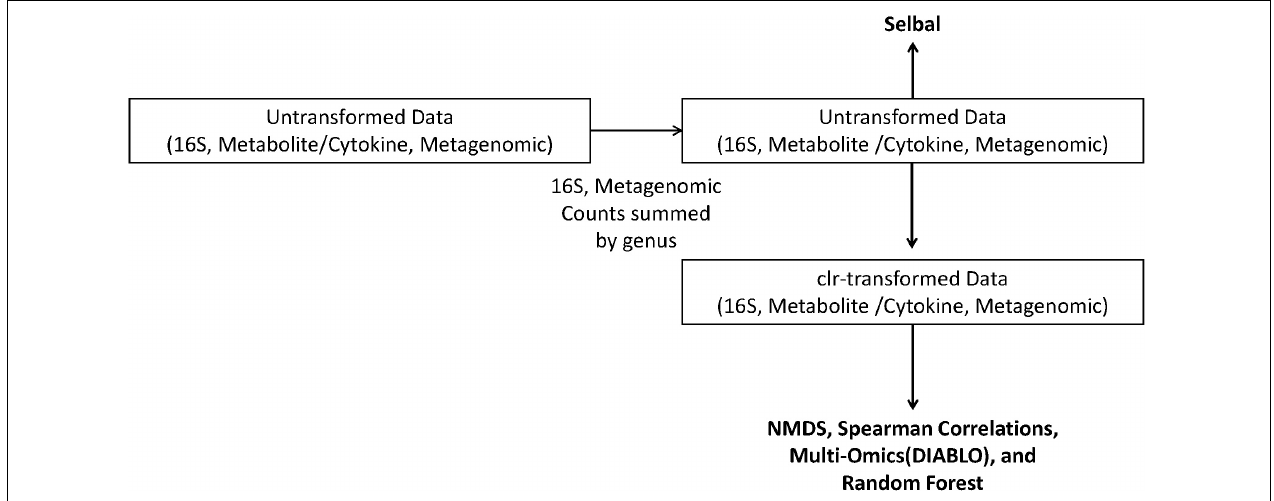
FIGURE 1 | Schematic of the analyses performed on the centered log-ratio (clr)-transformed periodontal treatment (PT) and sodium hypochlorite (SHT) data. Only untransformed data were inputted into selbal, and clr-transformed data were used to calculate Spearman’s correlations, non-metric multidimensional scaling (NMDS), and DIABLO